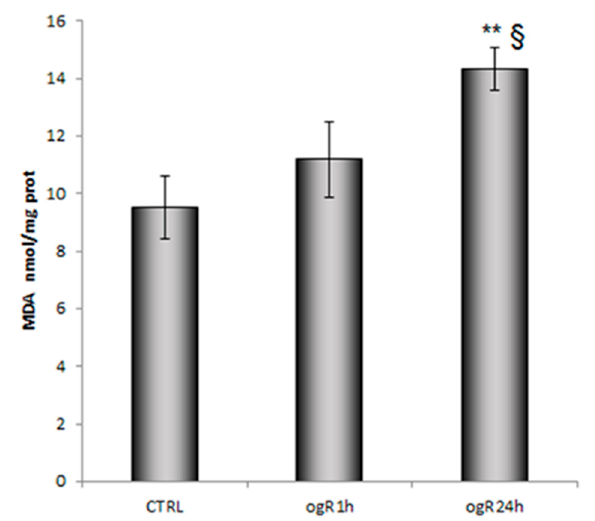
Figure 3. Evaluation of lipid peroxidation in RBE4 after OGD / ogR. Lipid peroxidation was evaluated by measuring malondialdehyde (MDA) content in control and OGD / ogR RBE4 cells as marker of lipid peroxidation by HPLC- Evaporative light scattering detector (ELSD) system. The data are normalized to cellular protein content (nmol / mg protein) and expressed as mean ± S.E from three independent experiments, ** p < 0.01 vs. control, § p < 0.05 vs. ogR1h.